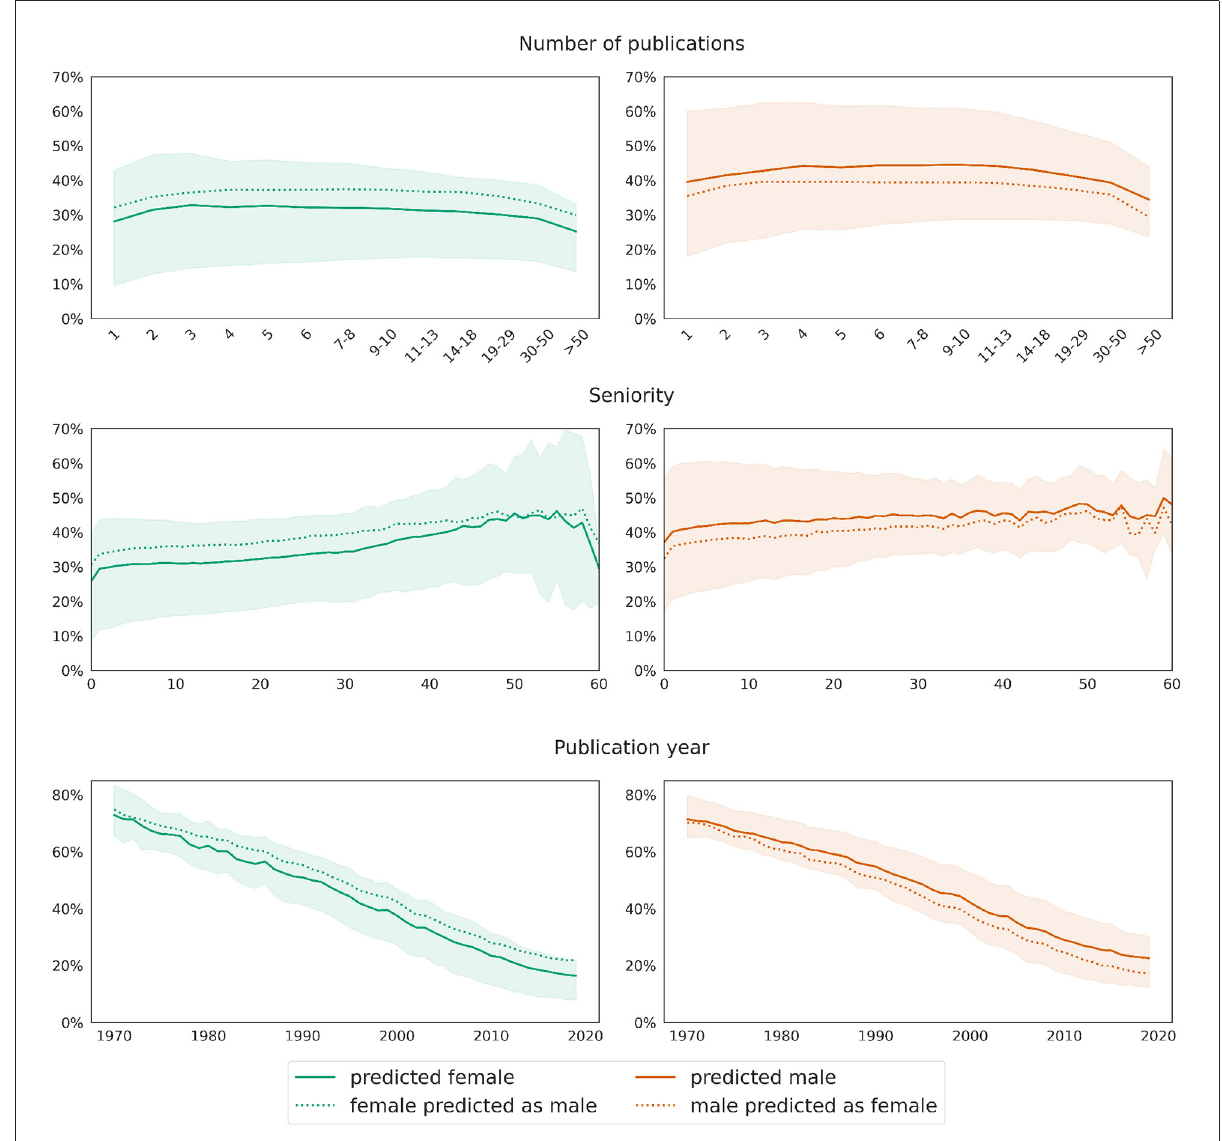
FIGURE10 Gender swapping approach: deviations in the value distributions of predictions applied to real data (solid curves) and data with swapped gender values (dotted curves) for the target variable number of single authorships . The curves show mean values, while shaded areas mark the [25,75] confidence interval of the predictions on real test